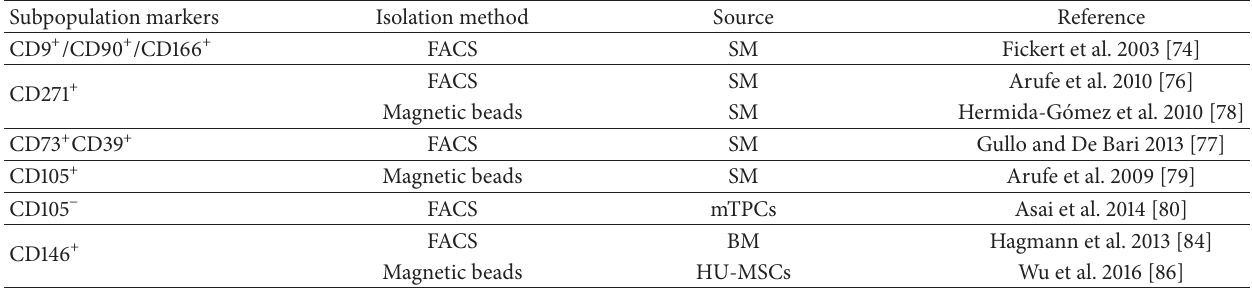
Table 2: MSC subpopulations with enhanced chondrogenic